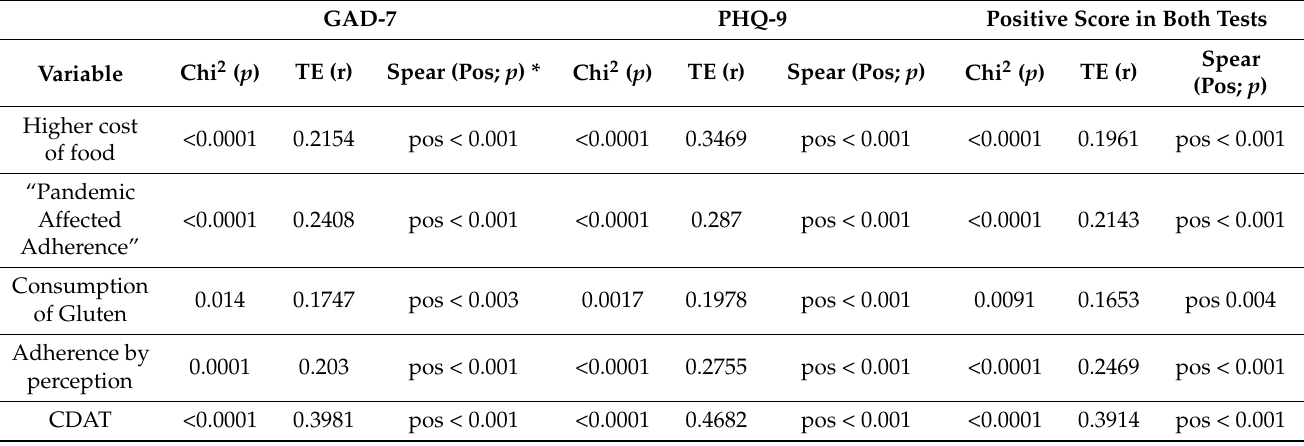
Table 4. Associations of positive anxiety (GAD-7) and depression (PHQ-9) scores with pandemic effects and adherence to diet (by perception and